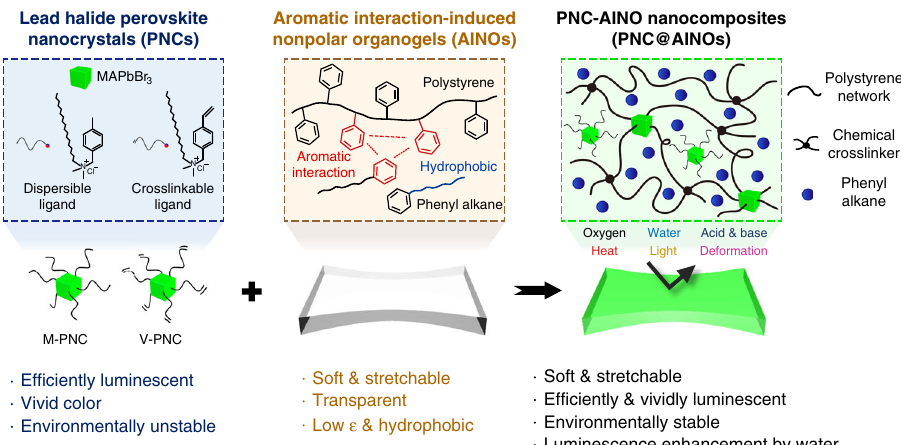
Fig. 1 Mechanically soft, ef fi ciently luminescent, and environmentally stable perovskite nanocomposites. Synergistic combination of two materials: (i) methylammonium lead bromide (MAPbBr 3 ) PNCs composed of physically dispersible ligand (M-PNC) or chemically crosslinkable ligand (V-PNC) as highly ef fi cient and pure green emitters, with (ii) aromatic interaction-induced nonpolar organogels (AINOs) consisting of polystyrene network swollen by phenyl alkanes as passivating matrices for the PNCs. Due to the nonpolar and hydrophobic nature of the AINO, the resulting nanocomposites (PNC@AINOs) complement the luminescence and mechanical property of their parents without trade-off, while their nonpolar environment enhances luminescence stability under various environments, such as air (oxygen), water, acid, base, heat, light, and mechanical stress. Furthermore, the luminescence ef fi ciency of the PNC@AINO is increased after water exposure, reaching near unity (~99.8%). ε dielectric